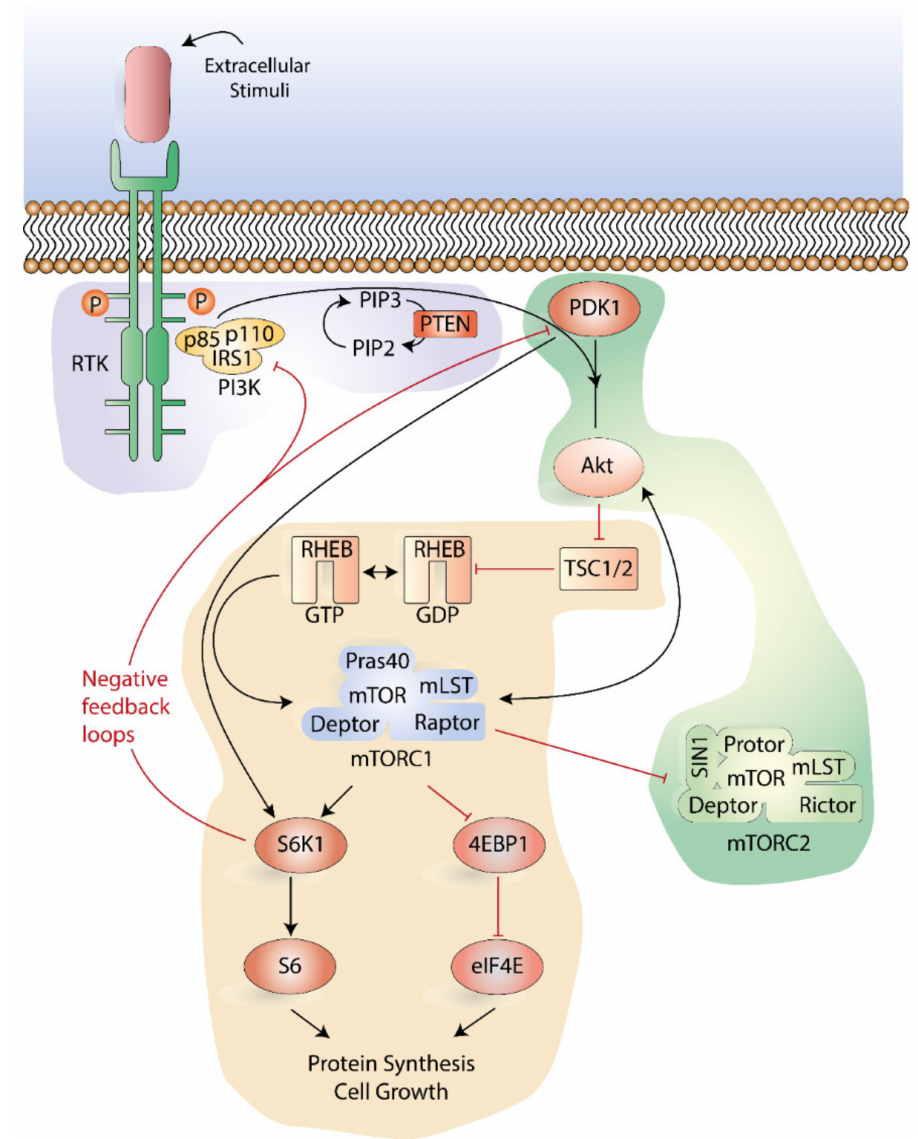
Figure 1. Overview of the phosphoinositide 3-kinase-Akt-mammalian target of rapamycin (PI3K-Akt-mTOR) signaling pathway. Following ligation of cell surface receptors (e.g., growth factor receptors) phosphorylated receptor tyrosine kinases (RTK) recruits scaffolding proteins, which bind to the regulatory p85 subunit of PI3K. A subsequent activation of the catalytic subunits of PI3K generates phosphatidylinositol 3,4,5- trisphosphates (PIP3). Phosphoinositide-dependent kinase-1 (PDK1) and Akt proteins are then recruited to the plasma membrane, inducing the phosphorylation of Akt on Thr308 by PDK1. This is followed by activation of Akt on Ser473 by the mTOR complex 2 (mTORC2); this second phosphorylation is necessary for complete activation. Akt controls the activation of mTOR complex 1 (mTORC1) by constraining the GTPase activity of the TSC1 / TSC2 complex towards the Ras-related GTP-binding protein ras homologue enriched in brain (RHEB) that associates to mTORC1 and phosphorylates mTOR. The mTORC1 induces cap-dependent messenger RNA (mRNA) translation by phosphorylating 4EBP1, leading to the formation of eIF4F and the inhibition of autophagy. Both mTORC1 and PDK1 can directly activate S6K1, which in turn activates S6, and hence facilitates protein synthesis and cell growth. Positive regulation (activation / stimulation) of the pathways is presented as black arrows, and negative regulation (inhibition) of the pathways is presented as red blunt-ended lines. The abbreviations shown in the figure can be found in the list of